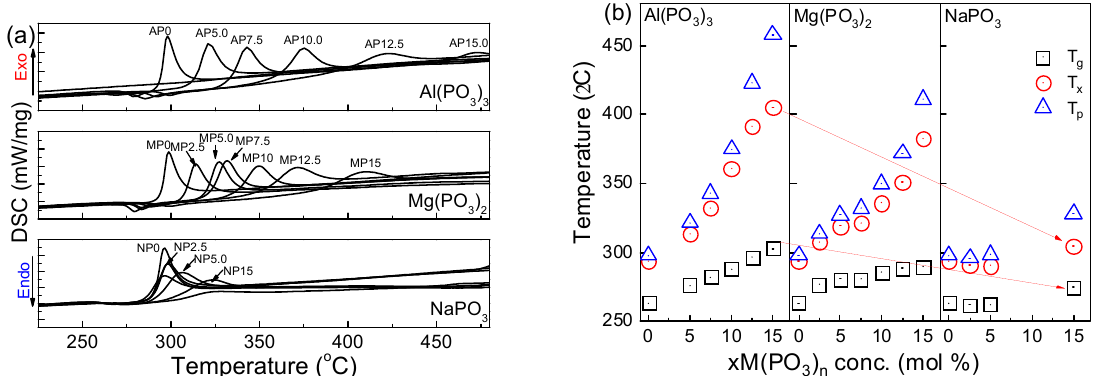
Figure 3. Effect of M(PO 3 ) n concentration on thermal properties in V 2 O 5 -5ZnO-22BaO-3B 2 O 3 -xM(PO 3 ) n (where M = Al, Mg, Na mol%, n = 3, 2, 1, respectively) glass system. ( a ) DSC curves, ( b ) glass transition temperature (T g ), crystallization onset temperature (T x ) and peak crystallization temperature (T p ).